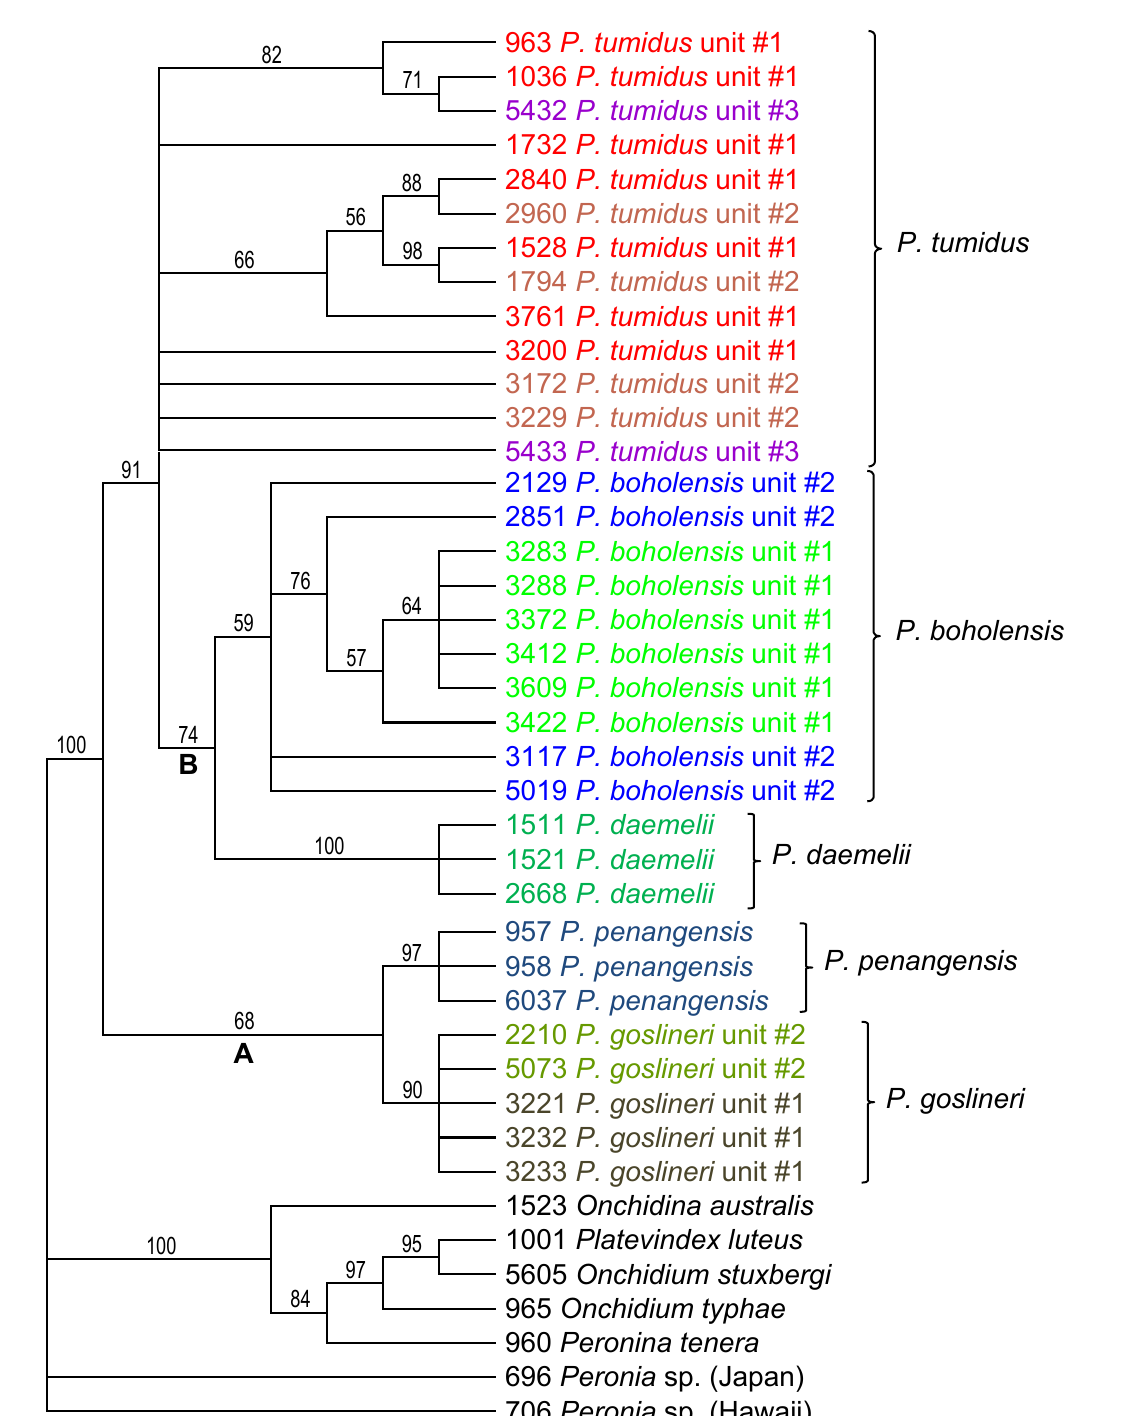
Fig. 3. Maximum parsimony consensus tree within Paromoionchis gen. nov., performed with concatenated ITS2 and 28S DNA sequences from 41 individuals (including 7 outgroups). Numbers by the branches are the bootstrap values (only numbers > 50% are indicated). Numbers for each individual correspond to unique identifiers for DNA extraction. All sequences for specimens of Paromoionchis gen. nov. are new. Information on specimens can be found in the lists of material examined and in Table 1. Letters A and B correspond to clades referred to in the text. The color used for each (mitochondrial) unit is the same as that used in Figs 1–2 and